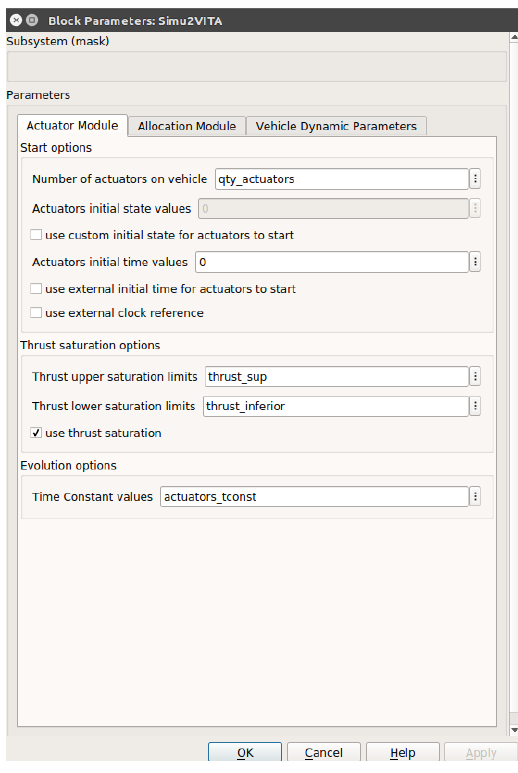
Figure A2. Simu2VITA interface for entering with simulation parameters for the Actuator Module. Information regarding the Dynamics Module involves scalars, matrices, and vectors presented on Sections 3.1.1 and 3.1.2. From the vehicle are required its mass, volume, center of gravity and its inertia matrix. For the hydrodynamics parameters, the added mass, linear and non-linear damping factors, and the water current velocity are also needed. Observe that the damping factors are considered diagonal matrices; thus, the input is a column vector for both fields. The hydrostatic parameters are the gravity constant, the water constant and center of bouyancy of the vehicle. The last two parameters are the initial pose and the initial velocity of the vehicle. See Figure